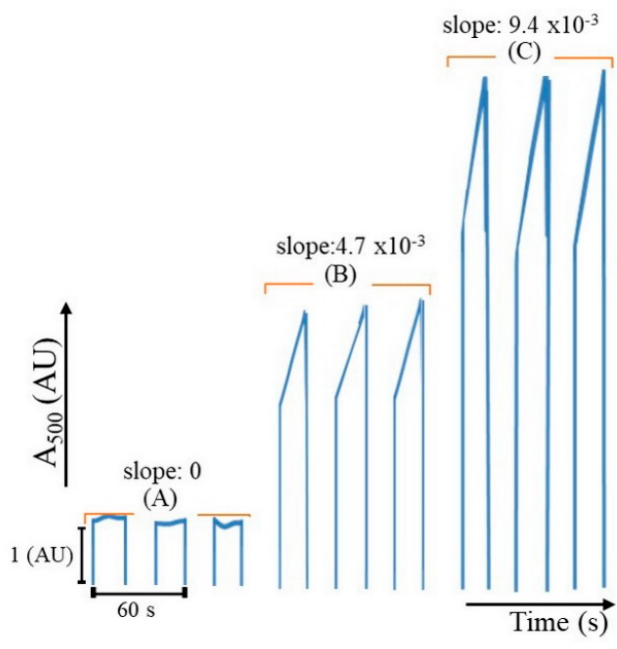
Figure 4. Analytical signal obtained from creatinine content in 200 µl ( A ) 0, ( B ) 10, and ( C ) 20 µg.